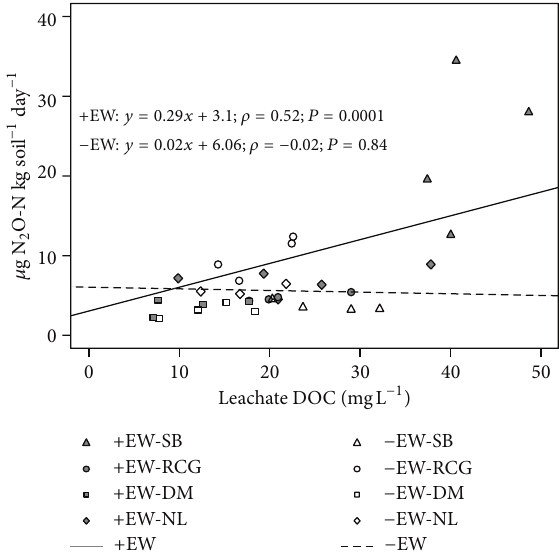
Figure 3: Scatter plot showing the functional relationship between CO 2 fluxandDOCconcentrationinleachate.Eachpointisthemean of 9 measurements taken of 1 of the 4 replicates during a 20 wks incubation study from microcosms filled with riparian soil that had earthworms present (EW, 𝑛 = 36 ) or no earthworms (NW, 𝑛 = 144 ) and received no litter (NL), soybean (SB), reed canarygrass (RCG), ordeciduous-mixlitter(DM)asthelittersource.Thelinearequation and standard error of the estimated slope of the line describe the functional relationship for EW and NW treatments, across litter types. The strength of the relationship is given as Spearman’s rank correlation coefficient ( 𝜌 ) and significance of each relationship ( P ).